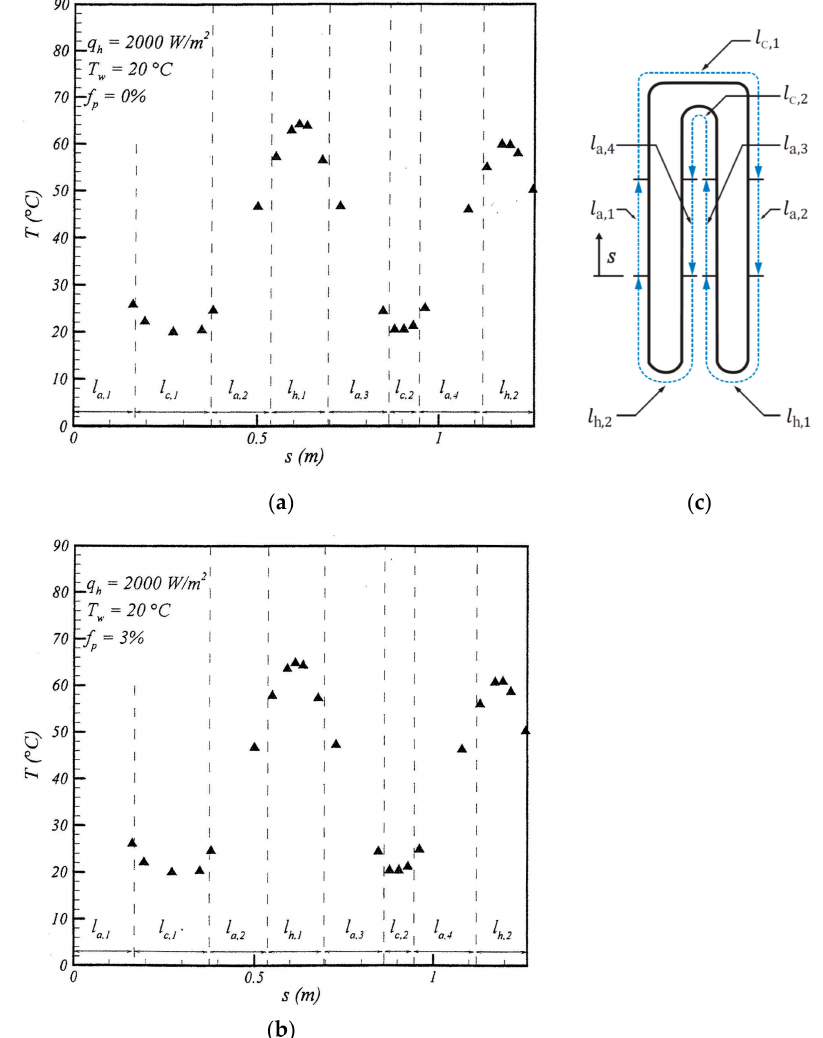
Figure 6. Steady-state temperature distribution of the fluid in the thermosyphon loop when q h = 2000 W/m 2 and T w = 20 ◦ C: ( a ) Pure water as the working fluid ( f p = 0%); ( b ) Pure water as the working fluid ( f p = 3%); ( c ) The experimental